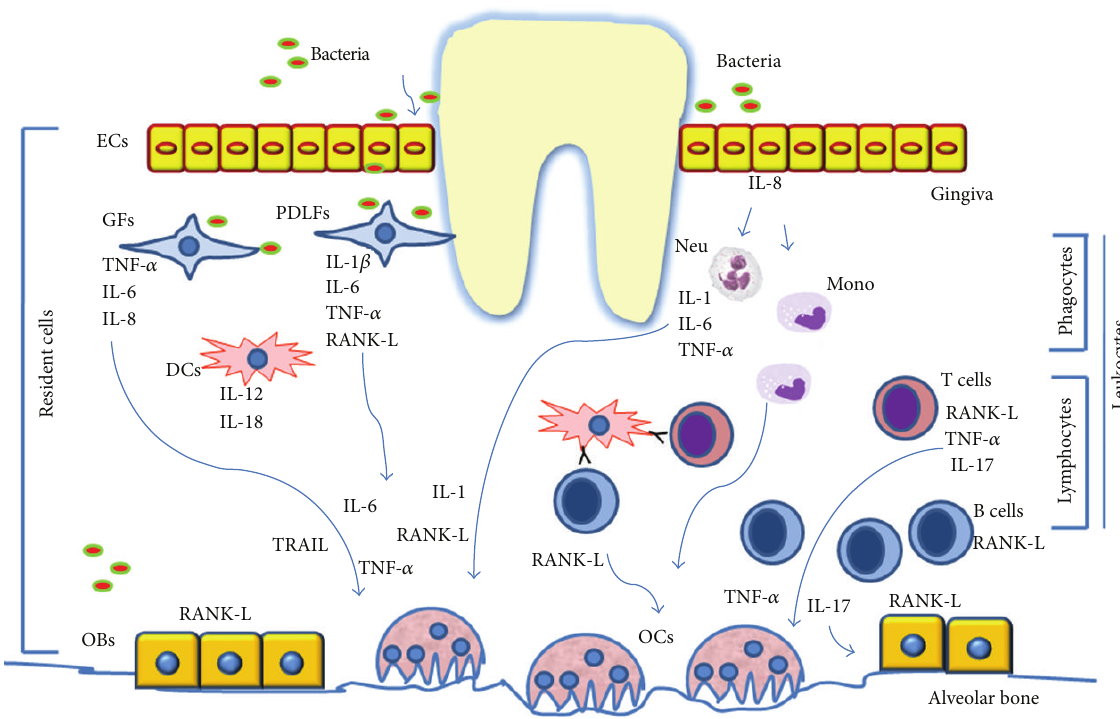
Figure 1: The network of cytokines, released by resident and migrating cells (lymphocytes and phagocytes), involved in periodontal bone resorption. Resident cells including epithelial cells (ECs), gingival fibroblast (GFs), periodontal ligament fibroblasts (PDLFs), osteoblast, and dendritic cells mediate the Innate Immunity. They respond to the bacterial challenge (via TLRs) by producing proinflammatory cytokinesandchemokines.ECsproduceIL-8,aneutrophilchemoattractant,whichrecruitsneutrophils(neu)andincreasesmonocyte(mono) adhesion. Neu in turn produces IL-1, IL-6, and TNF- 𝛼 , while Mono can differentiate into osteoclasts (OCs). DCs produce IL-12 and IL-18 but also act as antigen-presenting cells for B and T Cells. GFs produce IL-8, TNF- 𝛼 , and IL-6. PDLFs produce IL-1 𝛽 , IL-6, TNF- 𝛼 , and RANKL. Microorganisms can go deeper in the periodontal tissue and reach the surface of alveolar bone, promoting the expression of the proosteoclastogenic cytokine RANKL by osteoblasts (OBs). These inflammatory cytokines are directly (as RANK-L and TNF- 𝛼 ) or indirectly involved in osteoclastogenesis and are responsible for the alveolar bone loss. After this initial response (lasting approximately 21 days), activation of T and B cells by antigen-presenting cells initiates the adaptive immunity. As a result, tissues affected by periodontitis become colonized with both lymphocyte subtypes, but with a larger proportion of B cells than T cells. The majority of B cells in periodontal lesions are RANKL+. T cells produce the proosteoclastogenic cytokines RANKL and TNF- 𝛼 , and IL-17 which exerts its osteoclastogenic activity by enhancing RANKL expression on osteoblasts. Furthermore a new role for TRAIL, produced in periodontitis, is emerging in promoting osteoclastogenesis and favoring OBs